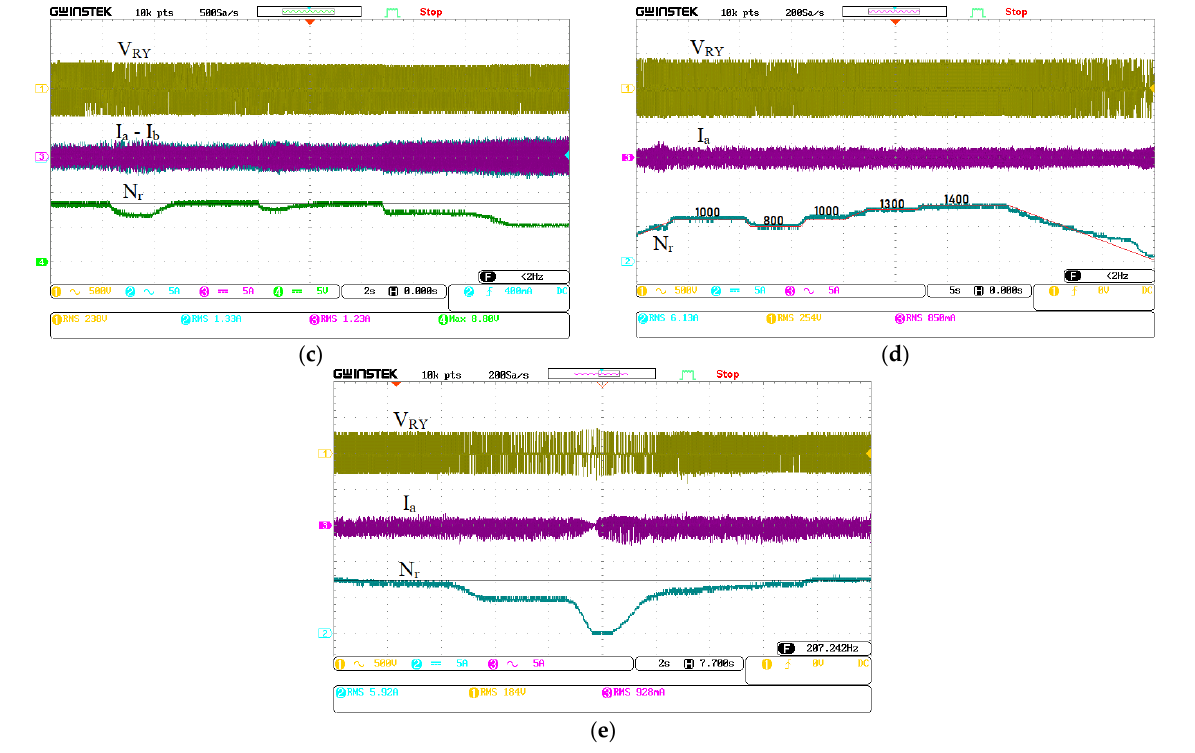
Figure 14. Experimental dynamic behaviors of induction motor supplied through DSI indicating various driving conditions: ( a – d ) dc voltage fed from the main source, and ( e ) dc voltage fed from the supplementary source.